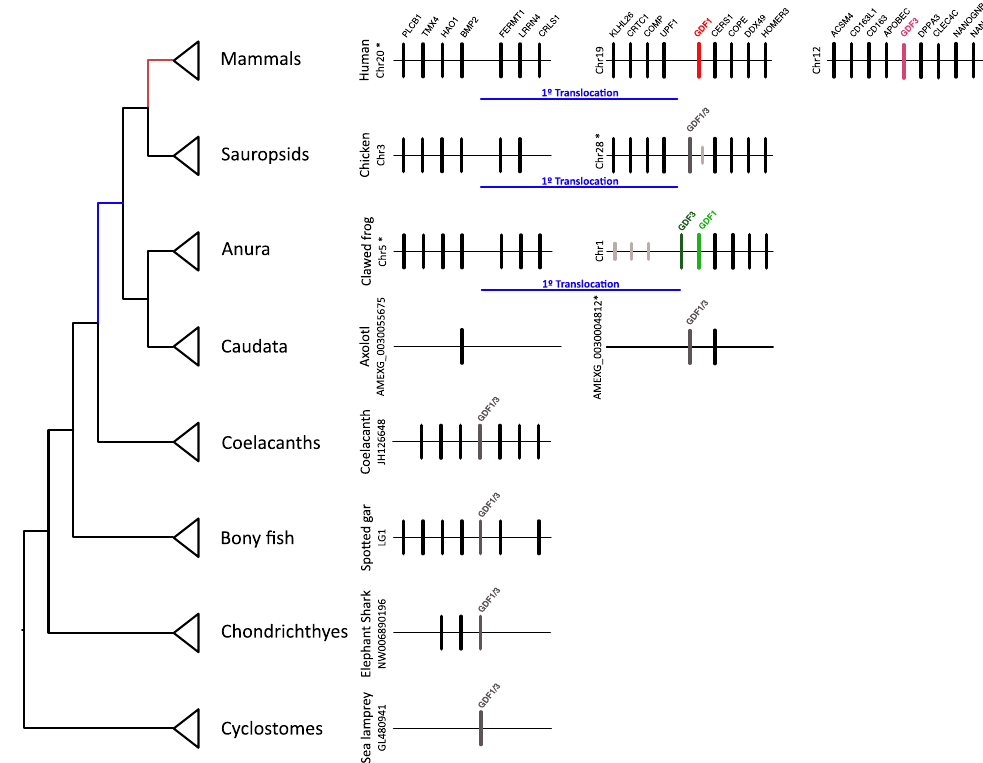
Figure 3. Structure of the chromosomal region containing the GDF1 and GDF3 genes of vertebrates. Asterisks denote that the orientation of the genomic piece is from 3 ′ to 5 ′ , gray lines represent intervening genes that do not contribute to conserved